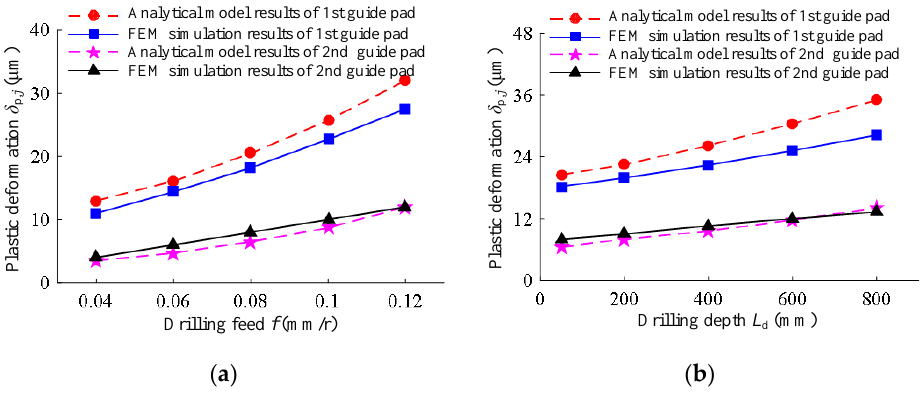
Figure 11. Plastic deformation according to the analytical model results and FEM simulation results: ( a ) under different drilling feeds of drilling speed n = 1200 r/min and drilling depth L d = 50 mm; ( b ) under different drilling depths of drilling speed n = 1200 r/min and feed rate f = 0.08 mm/r.